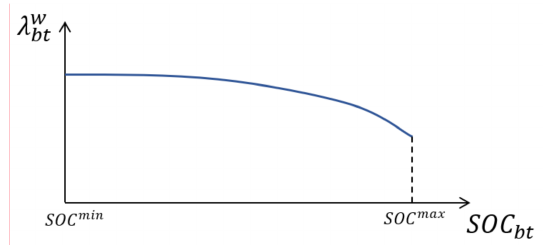
Figure 1. Weight of e ff ective capacity as a function of the state of charge of the